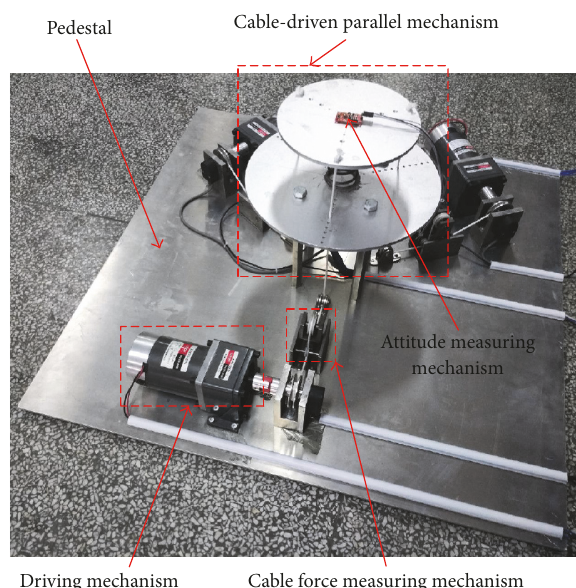
Figure 2: Prototype of the cable-driven parallel robot with a flexible